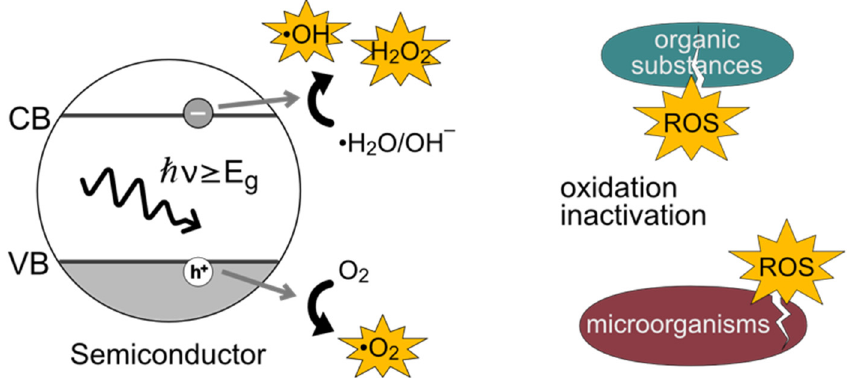
Figure 1. Mechanism of ROS generation on the surface of semiconducting nanoparticles and the effects of ROS activity on organic substances and microorganisms.